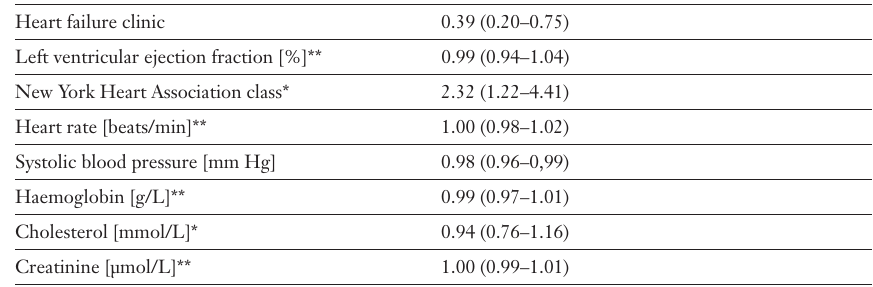
Table 2 Hazard ratios with 95% confidence inter- vals for the evalua- tion between the baseline variables and occurrence of heart failure rehospi- talisation or death during the follow-up.